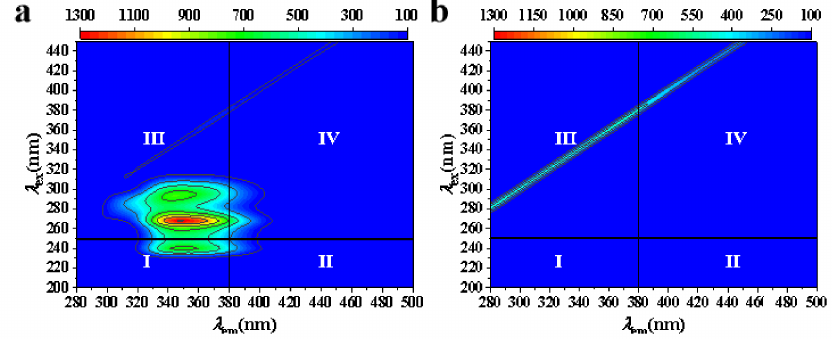
Figure 5. Three-dimensional-EEM spectra of ( a ) the pharmaceutical wastewater and ( b ) the treated